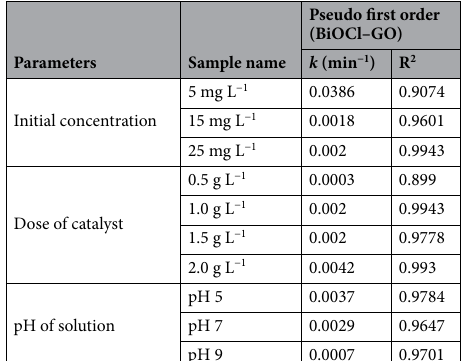
Table 2. The kinetics data of DCF degradation by BiOCl-GO for initial DCF concentration, catalyst mass and solution pH.